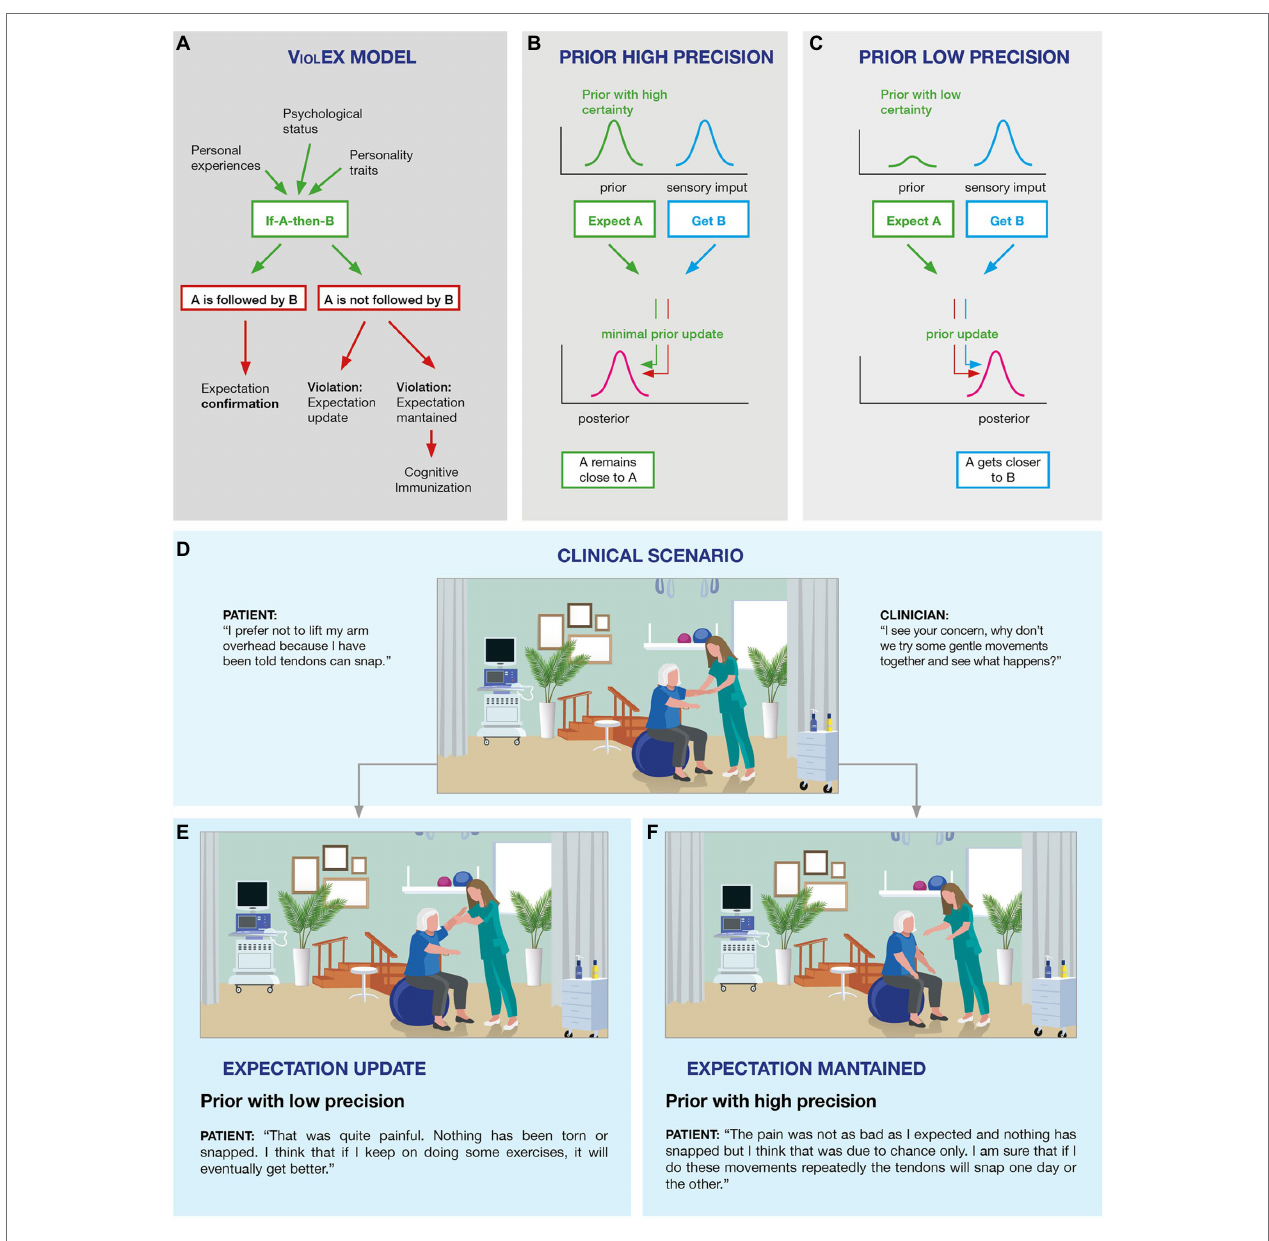
FIGURE 1 | The ViolEx Model and the Bayesian Brain: from theory to clinical practice in musculoskeletal (MSK) pain. The ViolEx Model (A) and the Bayesian brain (B,C) . Image (A) is a schematization of the ViolEx Model showing different outcomes depending on whether the violation of expectations is followed by immunization or change, resulting in either expectations maintenance or expectations updating, respectively. Image (B) is an example in which a prior with a high level of certainty is considered reliable and therefore undergoes minimal updating, while the interpretation of the sensory data is shifted toward the prior, resulting in a biased percept. Image (C) is an example in which a prior with a low level of certainty is updated to better fit sensory data, resulting in a posterior which is a better proxy of the sensory information. Examples of clinical scenarios (D–F) . Image (D) shows a typical clinical situation in which the clinician asks the patient with MSK pain to perform a basic exercise (lift the arm), while the patient is reluctant to do it due to their negative expectations (i.e., pain/injury). The patient finally agrees and lifts the arm, without facing negative consequences. Such situation may result in two different outcomes: in (E) the positive experience associated with the exercise leads to the violation of the patient’s negative expectation with an update (low prior); whereas in (F) the positive experience associated with the exercise is not sufficient to violate the patient’s negative expectation, thus maintaining the previous experience (high